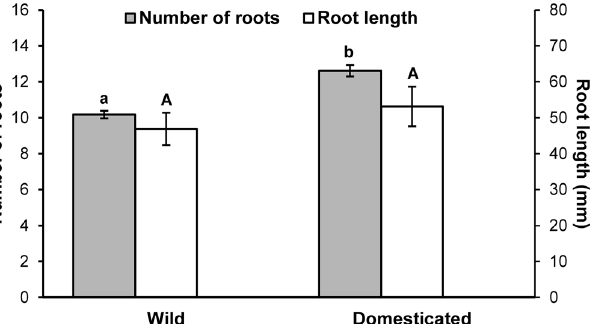
Figure 5. Number of main roots (number of roots) and length of the longest root (root length) of stem cuttings of wild and domesticated Cnidoscolus aconitifolius . Roots were counted and measured 1 month after being planted. Data are the mean ± 1 SE. Different letters indicate statistically significant differences between cuttings from wild and domesticated plants. Lower case letters correspond to the number of roots and upper case letters correspond to the length of the longest